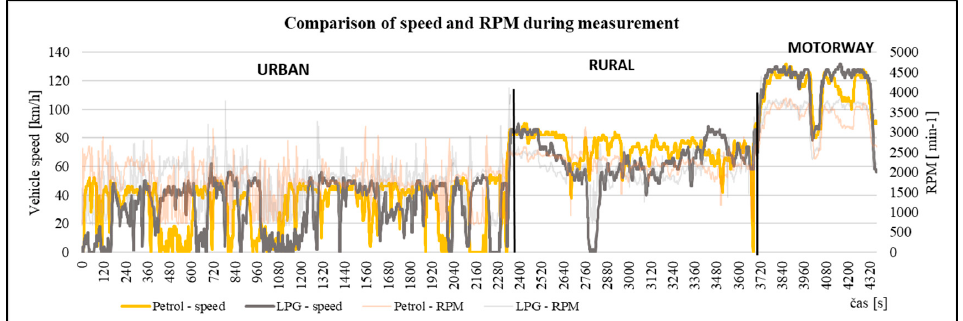
Figure 4. The course of speed and revolutions of the vehicle during the measurement [author].